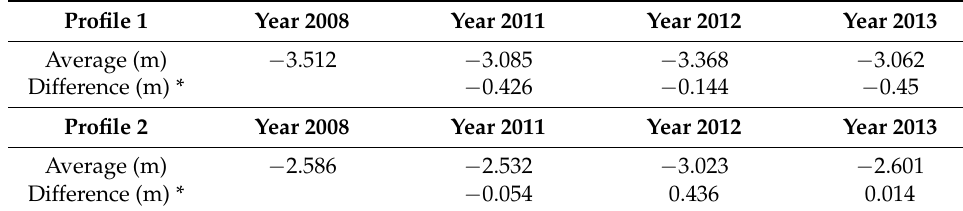
Table 3. Bathymetric changes in Tubul Bay, pre- and postearthquake in the 2008–2013 period. The main values are on the order of 0.40 m, indicating a decrease in depth.